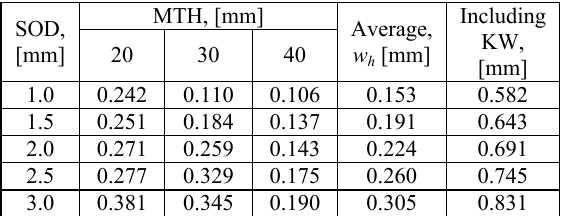
Figure 10. Hardness variation for 20mm MTH [11] Table 5. Hardened layer width, w h [mm] [11]